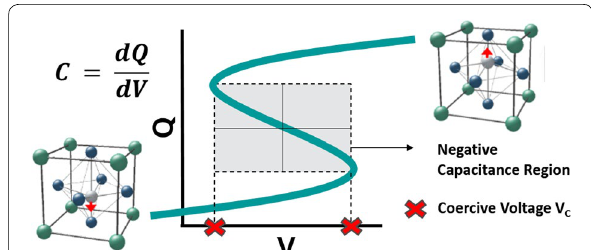
Fig. 2 Charge (Q) vs. voltage (V) characteristic of ferroelectric capaci- tor. The capacitance is defined as the variation of charge over the variation of applied voltage. The red-colored marks represent the coercive voltages of ferroelectric layer. As the externally applied bias becomes higher than the coercive voltages for forward/reverse volt- age sweep, the polarization switching occurs. This renders sudden charge reduction in ferroelectric capacitor. This is illustrated as the “S-shaped” curve in the Q vs. V